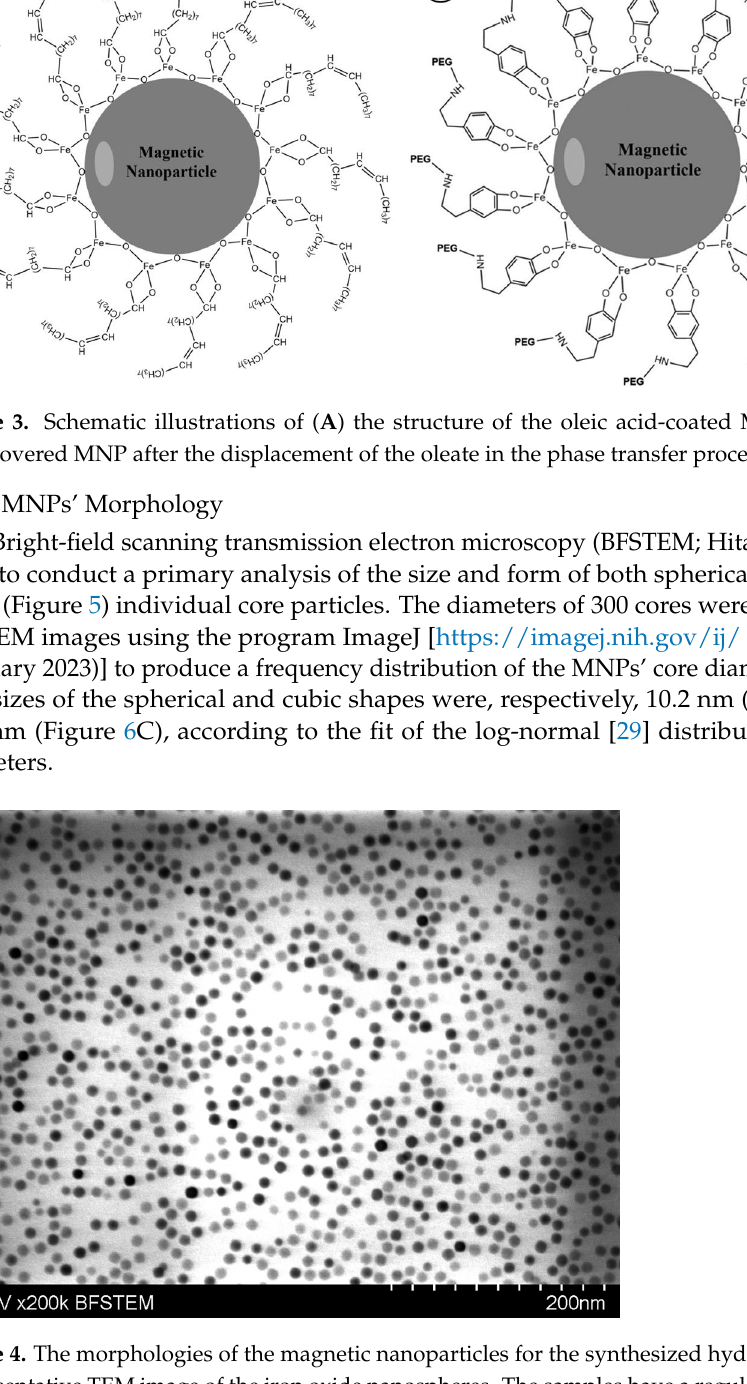
Figure 5. Representative TEM image of the core–shell iron oxide hydrophobic magnetic nanoparti- cles with the cubic structure of edge length of 15 ± 2 nm. TEM image of the cubic shape MNPs. The nanocubes have a very regular cubic shape without any edge truncations.